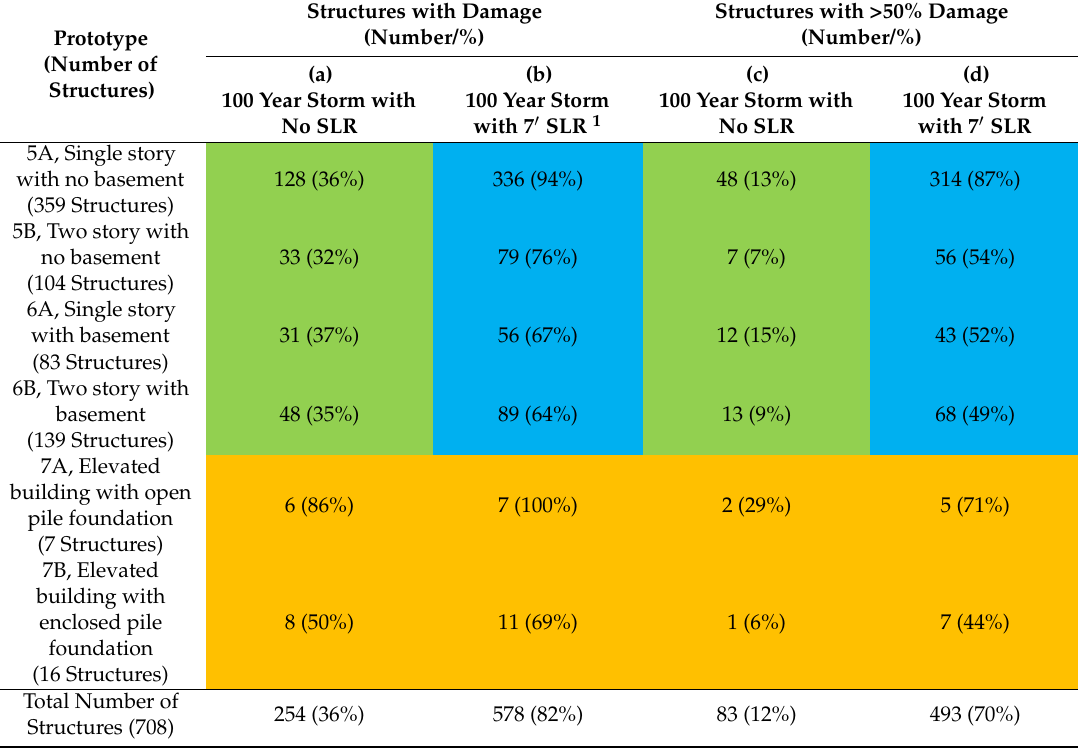
Table 1. Summary of the total damage estimates by prototype for a 100 year storm event with and without 7 feet of sea level